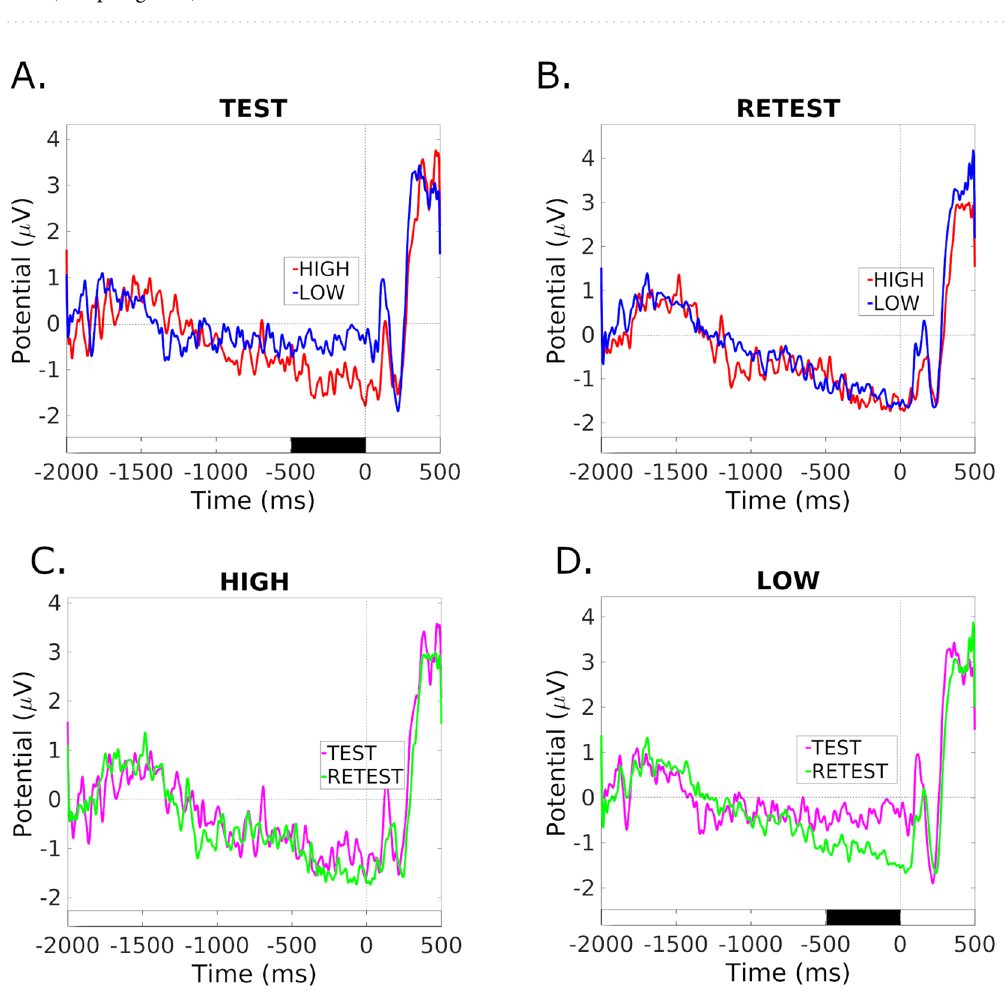
Figure 7. Grand average event-related potentials (ERPs) recorded from electrode Pz during the visual search task. ( A , B ): ERPs for the high-gB2rest (red) and low-gB2rest (blue) groups in the test ( A ) and retest ( B ) sessions. ( C , D ): ERPs from test (magenta) and retest (green) for the high ( C ) and low ( D ) GB2rest groups. Black bars denote the expectation window with significant differences between groups (p < 0.05, FDR corrected). Time 0 denotes target